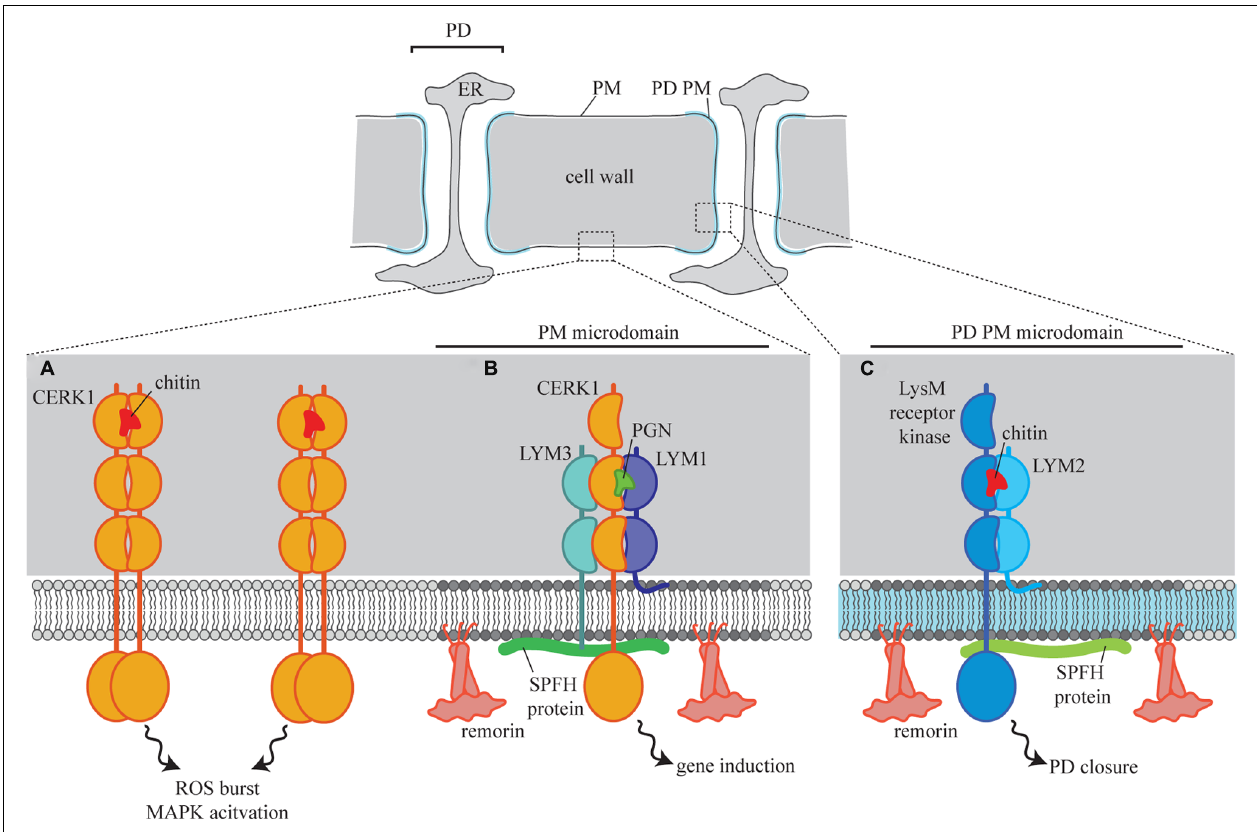
an unknown LysM receptor kinase. Remorin and SPFH proteins in the PD PM define lipid rafts which act as platforms for this signaling complex. In the cellular PM CERK1 is recruited to lipid rafts where it interacts with LYM1 and LYM3 to form a peptidoglycan (PGN) perception complex (B)